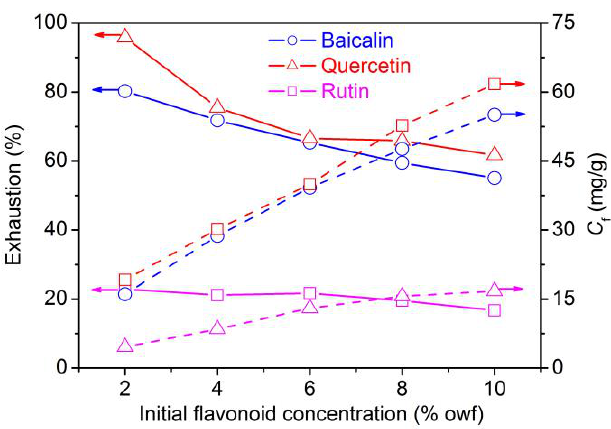
Figure 5. Uptake of flavonoids by polyamide fiber at different initial concentrations.